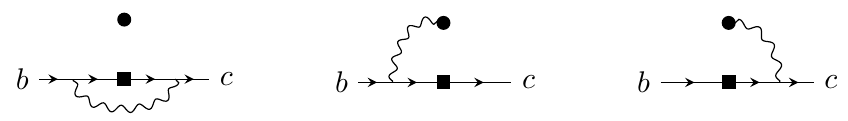
Figure 2 . α em -corrections to the heavy-to-heavy current. Here the dot represents the soft Wilson line S n +